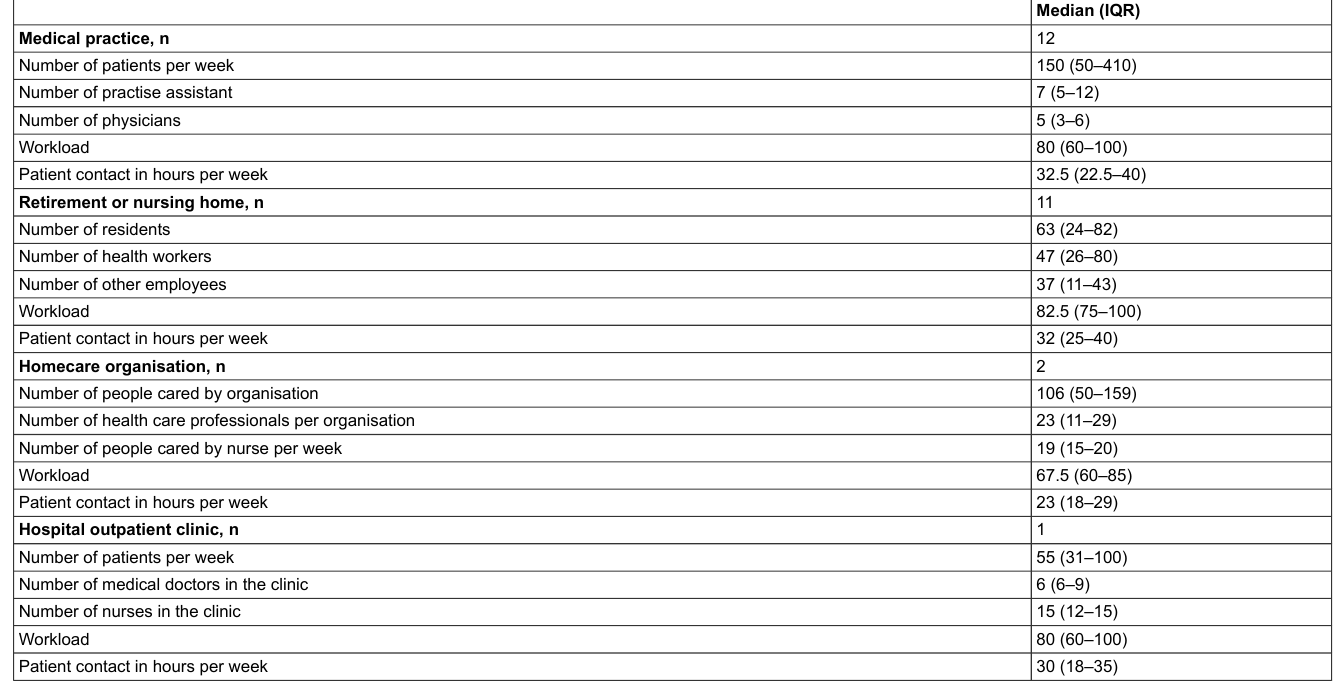
Table S1: Capacity of the individual healthcare facilities participating in the study (n = 26) during first wave of the COVID-19 pandemic.